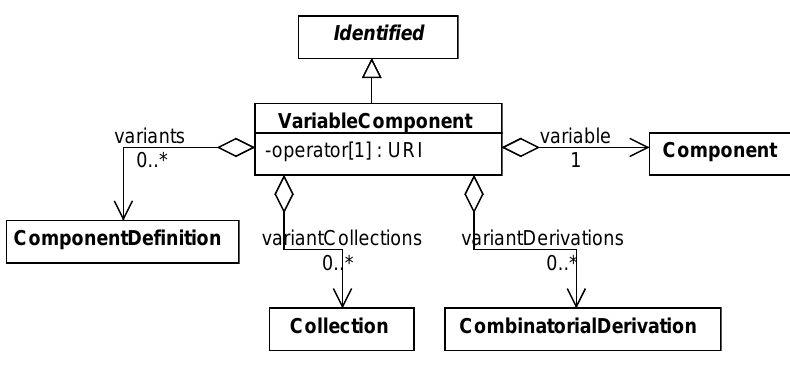
Figure 21: Diagram of the VariableComponent class and its associated